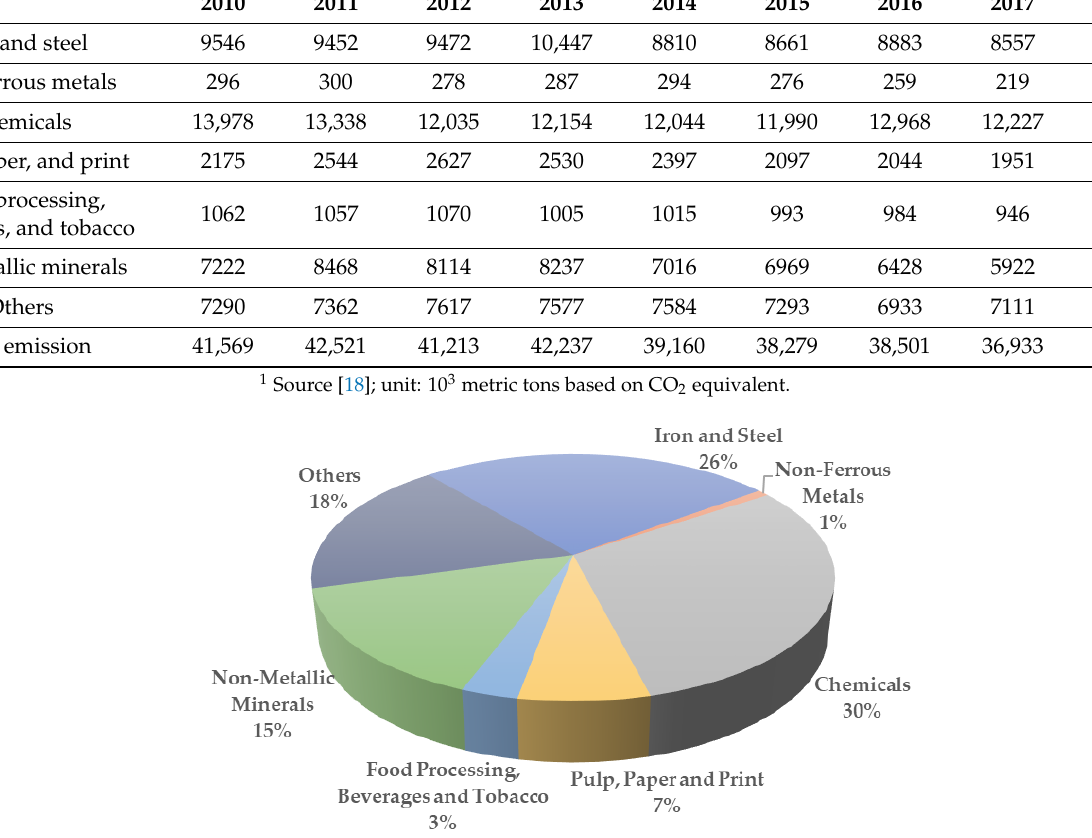
Figure 5. Pie chart of GHG emissions from the manufacturing and construction industries in terms of GHG sources in 2018 [18].